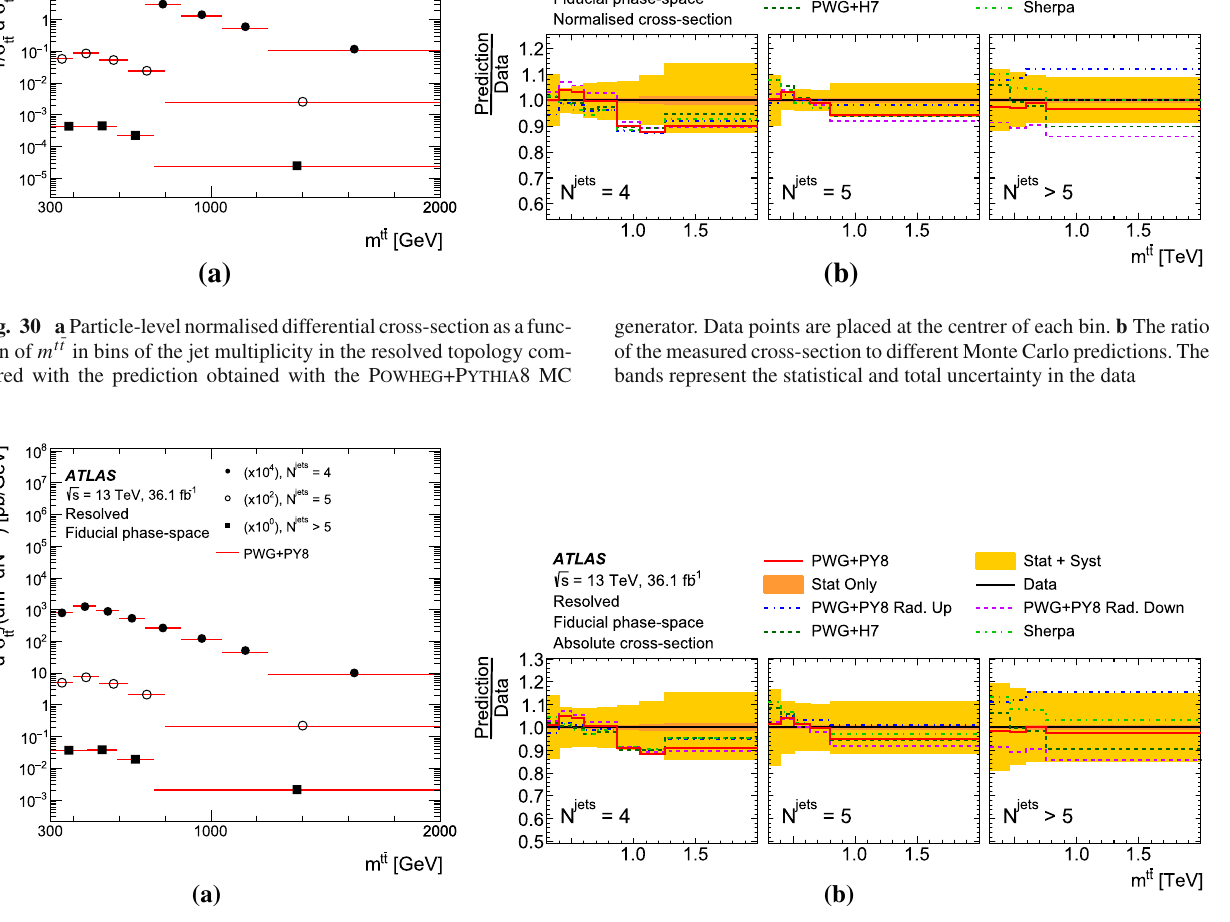
tor. Data points are placed at the centre of each bin. b The ratio of the measured cross-section to different Monte Carlo predictions. The bands represent the statistical and total uncertainty in the